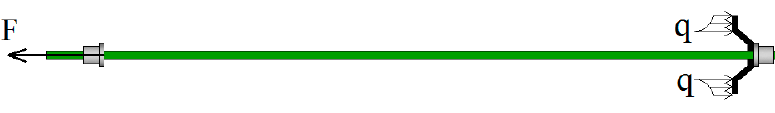
Figure 13. Onsite testing.